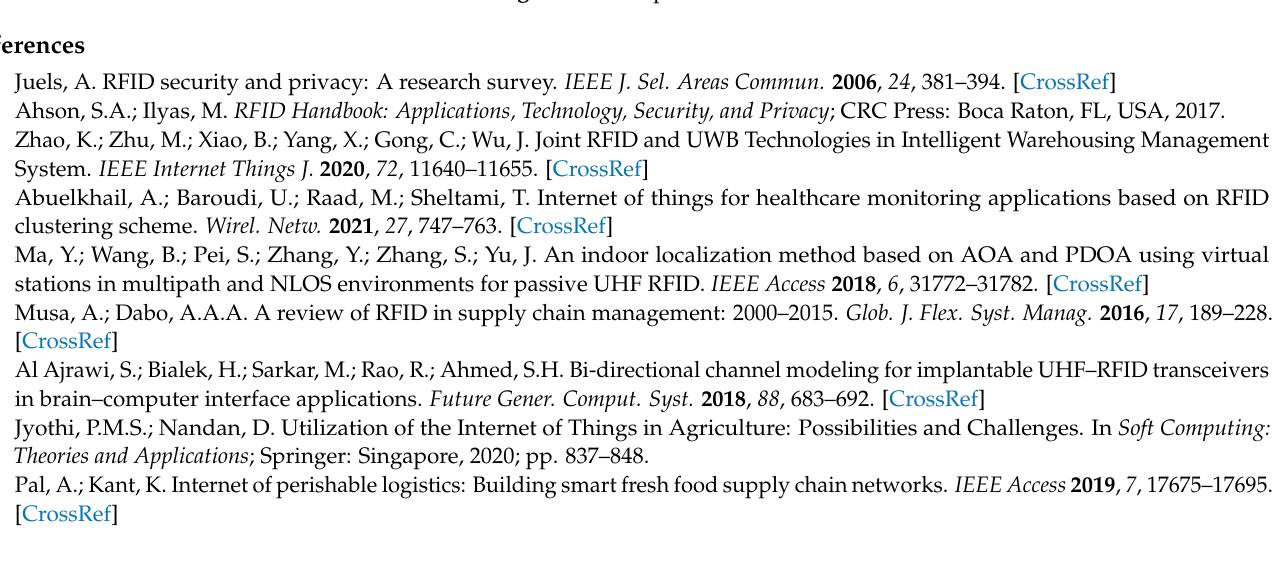
Figure A6. R13 Figure A6. R13 process.